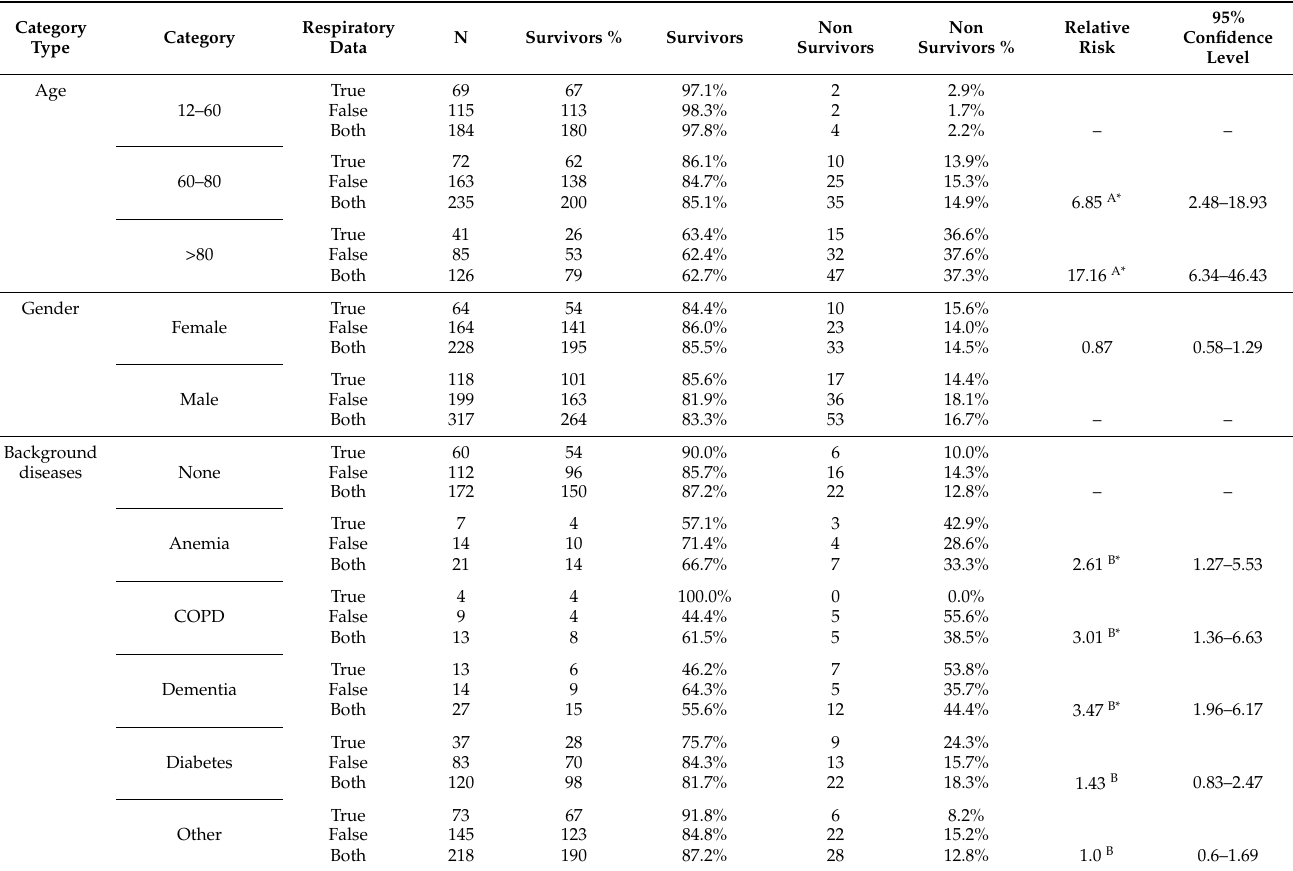
Table 2. Information on hospitalized patients with COVID-19 between 7 March 2020, and 16 March 2021, at Assuta Ashdod Medical